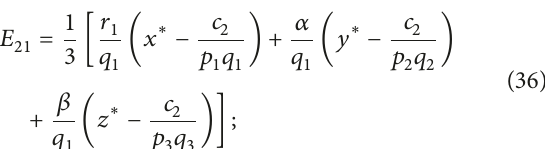
Table 5: The influence of the price on the